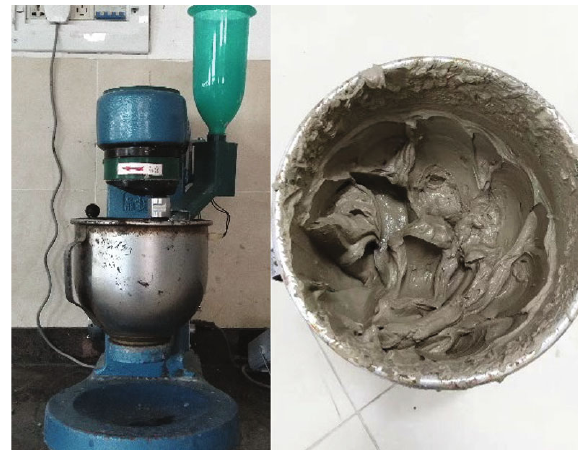
Figure 2: Mixing the components.